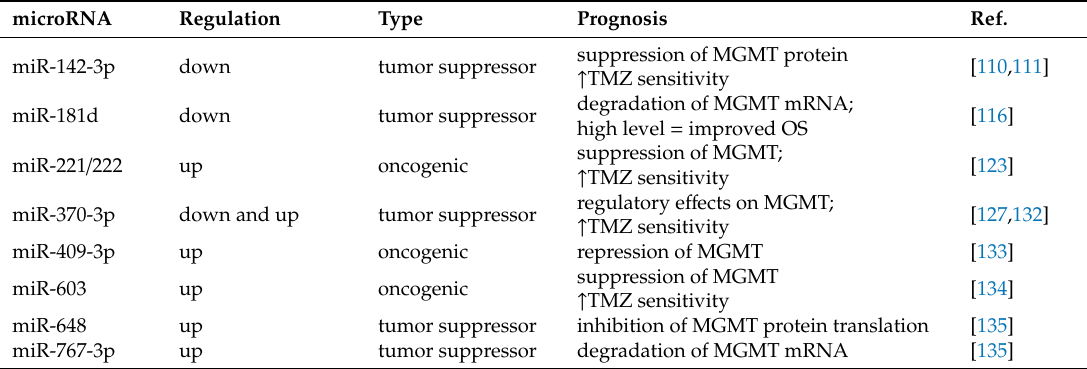
Table 3. miRNAs involved in MGMT regulation in Glioblastoma